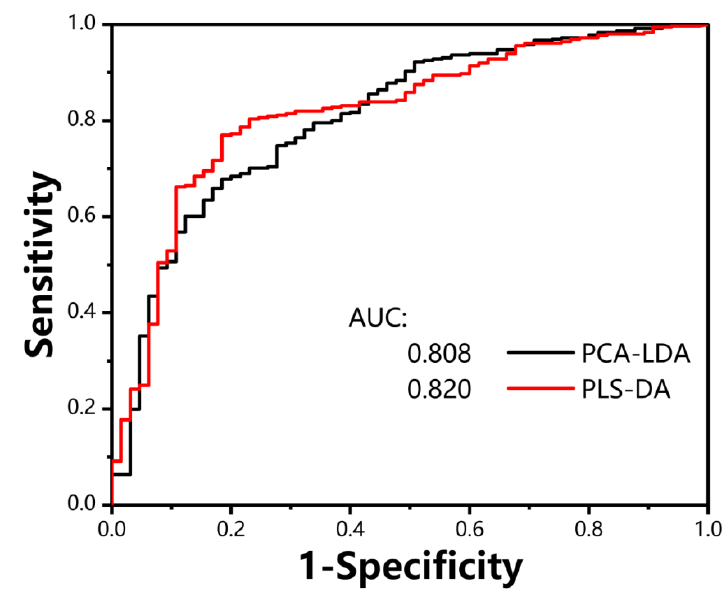
Figure 5. Receiver operating characteristic (ROC) curves for PCA-LDA and PLS-DA for intact and damaged sperm groups.